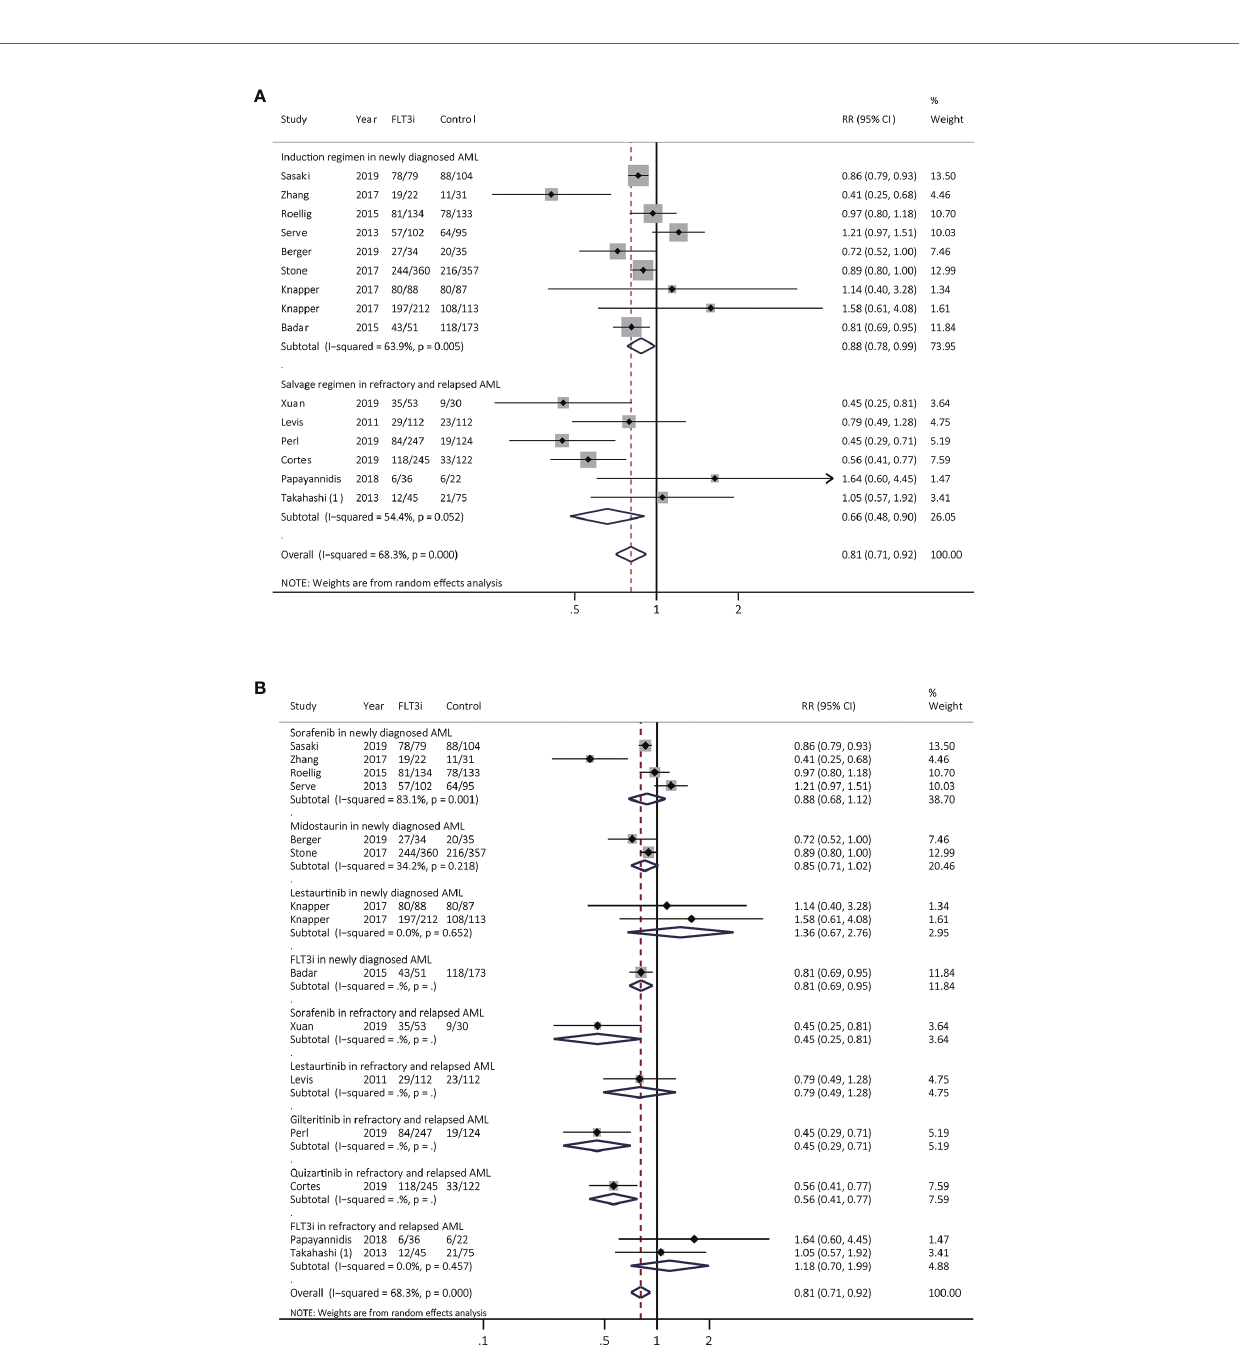
FIGURE 5 | Response to FLT3i during induction/reinduction treatment of newly diagnosed AML and FLT3(+) rrAML. (A) Pooled RR and 95% CI of all FLT3i during induction treatment and salvage regimen for CR; (B) Pooled RR and 95% CI of each FLT3i during induction treatment and salvage regimen for CR. FLT3, FMS-like tyrosine kinase 3; FLT3i, FLT3 inhibitor; AML, acute myeloid leukemia; rrAML, refractory and relapsed AML; CR, complete remission; RR, relative risk; 95% CI, 95% con fi dence